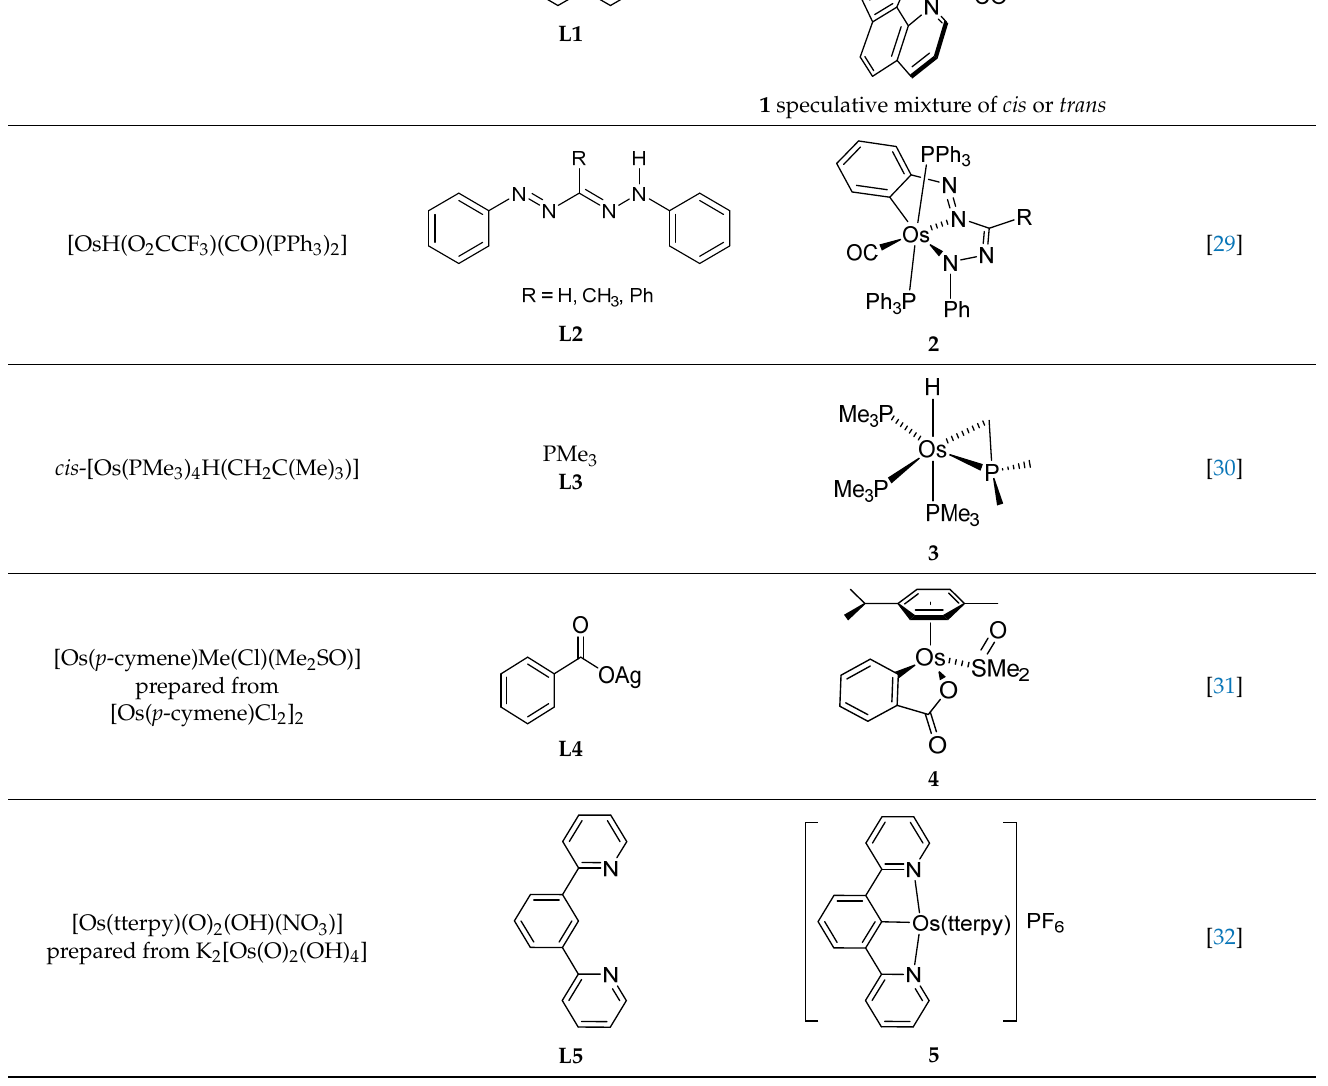
Table 1. First osmacycles prepared between 1973 and 1997.